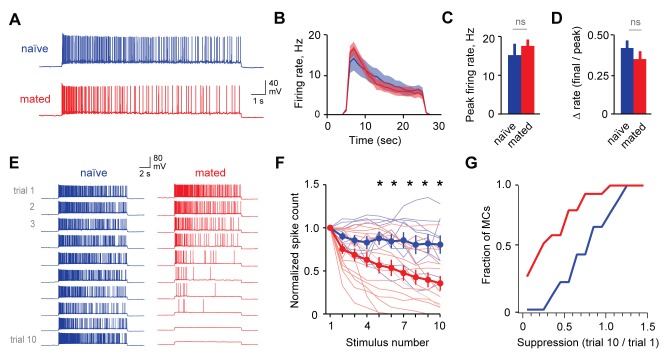
Mating reduces the responsiveness of MCs to repetitive inputs.(A) MC firing to an initial current stimulus is similar for naïve and mated females. (B) Firing rate profile averaged across all MCs from naïve and mated animals. (C, D) Mating has no effect initial MC output (peak firing rate: p=0.51; change in firing rate: p=0.55; t-test; n = 10 and 15 cells from 5 and 7 mice for naïve and mated groups respectively). (E) Example MC responses to repetitive stimulation. Firing is stable over time in naïve females, but drops dramatically over time after mating. (F) Average MC output across successive stimuli for naïve (blue) and mated females (red). Firing on 10th trial is 80 ± 11% (naïve) vs. 36 ± 8% of 1st trial (mated); F = 10.01, Fc = 4.30, p=0.003; ANOVA with post-hoc Tukey test. Light colors show individual neurons; dark traces show mean ± SEM. (G) Cumulative histogram showing increased attenuation in MCs from mated animals (p=0.027; Kolmogorov-Smirnov test; n = 9 and 15 neurons from 5 and 7 mice respectively). NS, not significant. *p<0.05; **p<0.01.DOI:
http://dx.doi.org/10.7554/eLife.25421.01610.7554/eLife.25421.017Figure 5—source data 1.This spreadsheet contains the firing rate and spike count data for mitral cells used to generate the bar plots and average data shown in Figures 5C, D and F.These data can be opened with Microsoft Excel or with open-source alternatives such as OpenOffice.